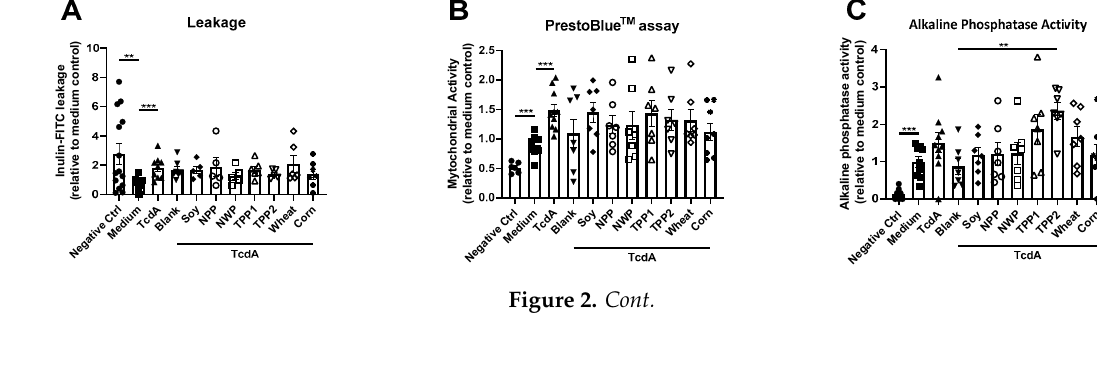
Figure 2. Potency of plant-based dietary protein to restore the effect of Clostridium difficile-secreted toxin A (TcdA) on bioengineered intestinal tubules. ( A – E ) Assessment of intestinal parameters after TcdA exposures, including ( A ) inulin-FITC leakage, ( B ) cell viability, ( C ) alkaline phosphatase activity, ( D ) release of IL-6 and ( E ) NO content. Data are presented as mean ± SD of at least a 6 independent experiments and corrected for outliers (excluding 24 out of 431 data points). Control groups (negative control, medium, TcdA and blank) were tested for significance using a Student's t - test. Protein sources were tested for significance using one-way ANOVA followed by Dunnett’s test (compared to blank), * p < 0.05, ** p < 0.005, and *** p < 0.001. ND, not detectable. The third series of experiments consisted of alternative-based dietary proteins originating from insect, yeast and fungi, that were evaluated for their restoring capabilities after Clostridium difficile- secreted TcdA exposure. Comparing six alternative-based protein sources to blank control, revealed no reparative effects on the intestinal epithelial integrity (Figure 3A), mitochondrial activity (Figure 3B), alkaline phosphatase activity (Figure 3C) or IL-6 (Figure 3D) after TcdA exposure. IL-8 was below the limit of detection for all alternative-based dietary proteins and was, therefore, not shown. However,